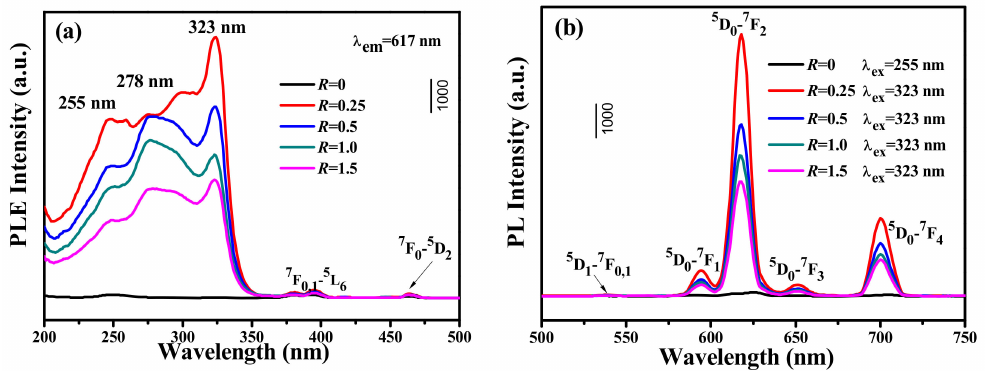
Figure 9. ( a ) PLE and ( b ) PL spectra for MC and MC- R V at room temperature. The decay kinetics of the 5 D 0 → 7 F 2 transition at 617 nm for MC and MC- R Vre a inves- tigated in Figure 11. All the fluorescence decay curves can be fitted to single